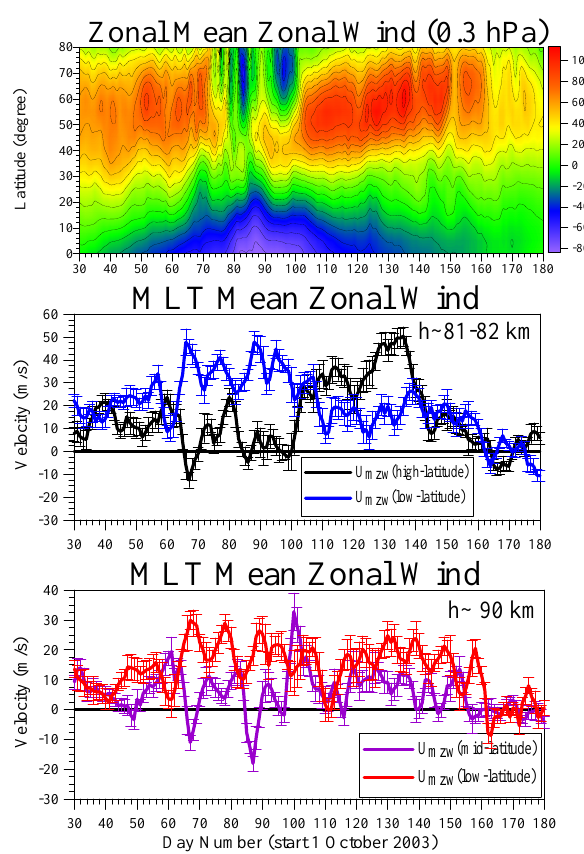
Figure 9 Fig. 9. Height-time cross section of the zonal mean zonal wind at pressure level 0.3hPa during the period of time between November 2003 and March 2004 (upper plot). The middle plot shows a com- parison between the calculated mean zonal winds at ∼ 81–82km for high (black) and tropical (blue) latitudes, while the bottom plot – a comparison between the mean zonal winds at ∼ 90km height for high-middle (purple) and tropical (red) latitudes (the error bars in- dicate the standard deviation of the